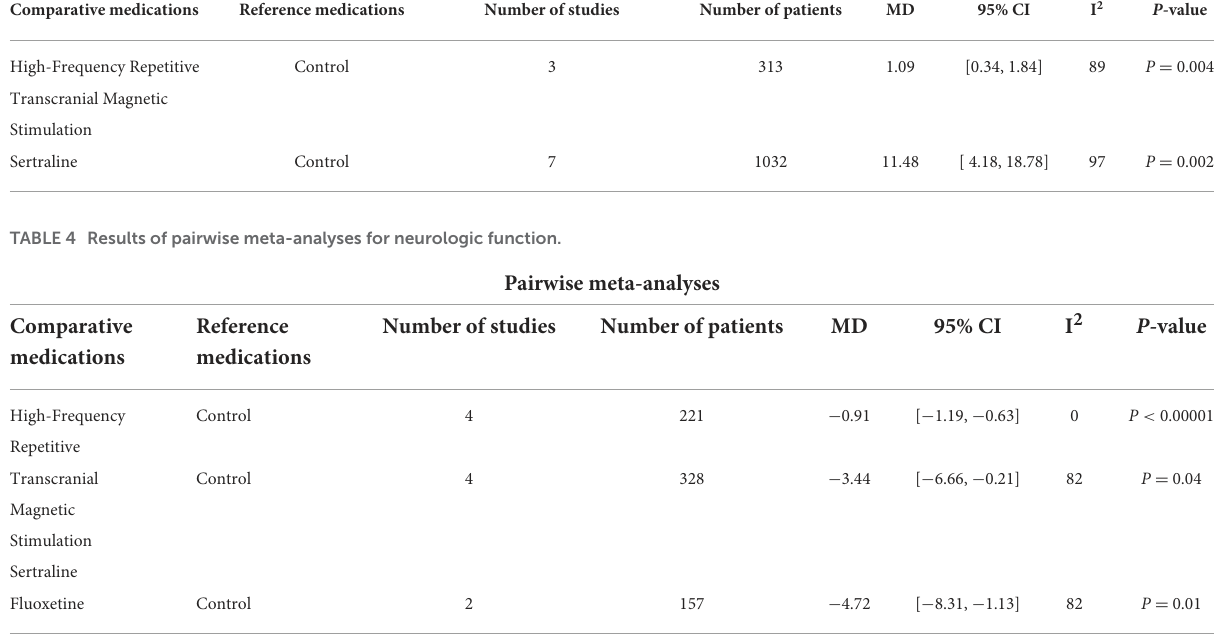
TABLE 3 Results of pairwise meta-analyses for ADL.